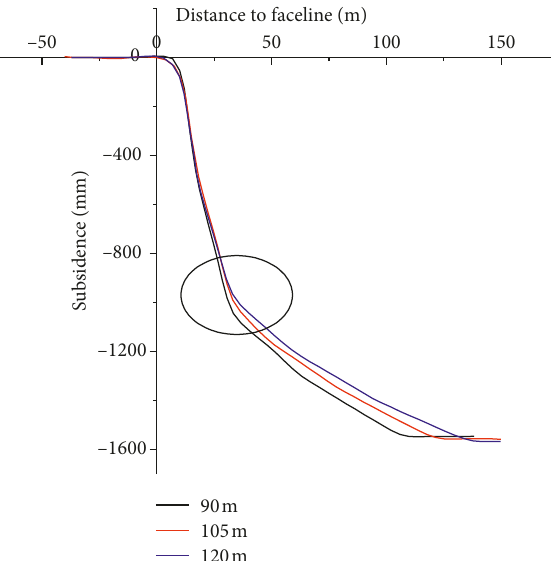
Figure 9: Influence of the width of the undercompacted zone on the subsidence of the voussoir beam